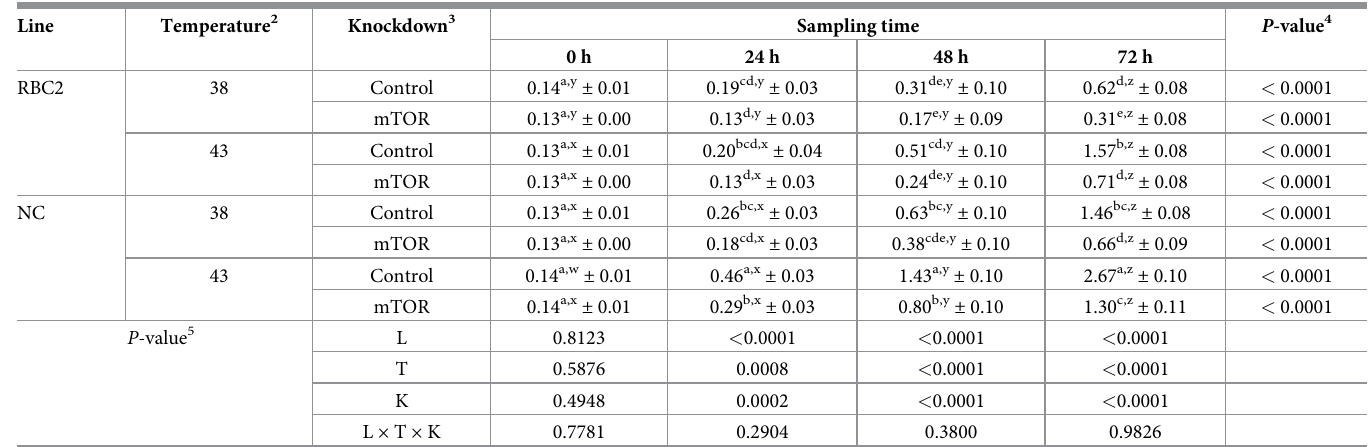
Table 2. Effect of heat stress (43˚C) and knockdown of mTOR on RBC2 and NC line SC proliferation 1